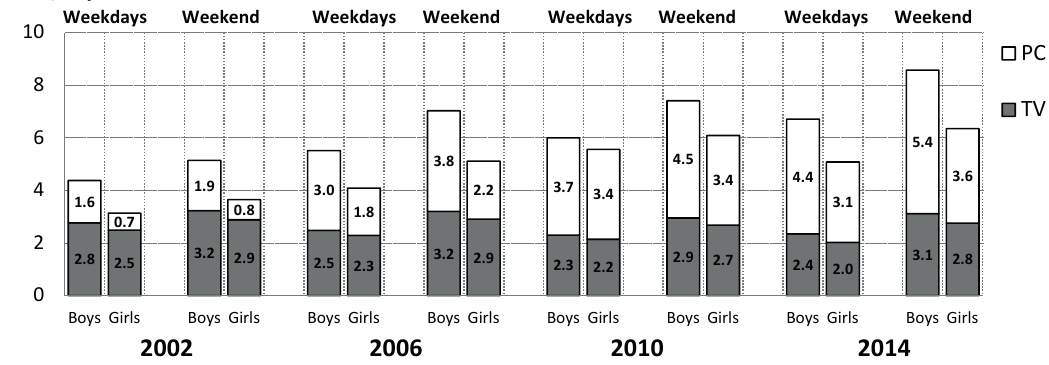
Figure 1. Mean daily hours of screen time among Czech adolescents between 2002 and 2014